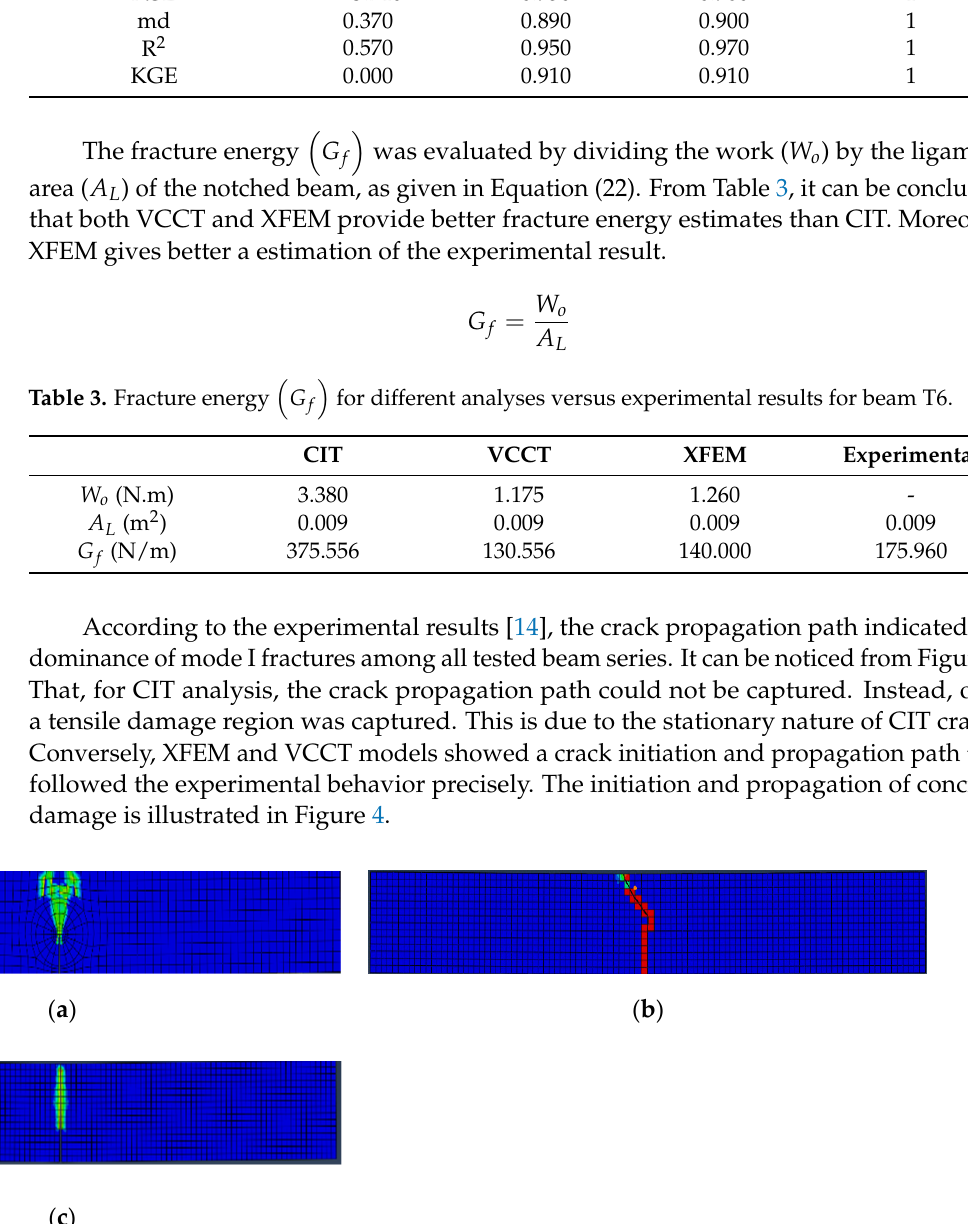
Table 2. Results of statistical indicators.